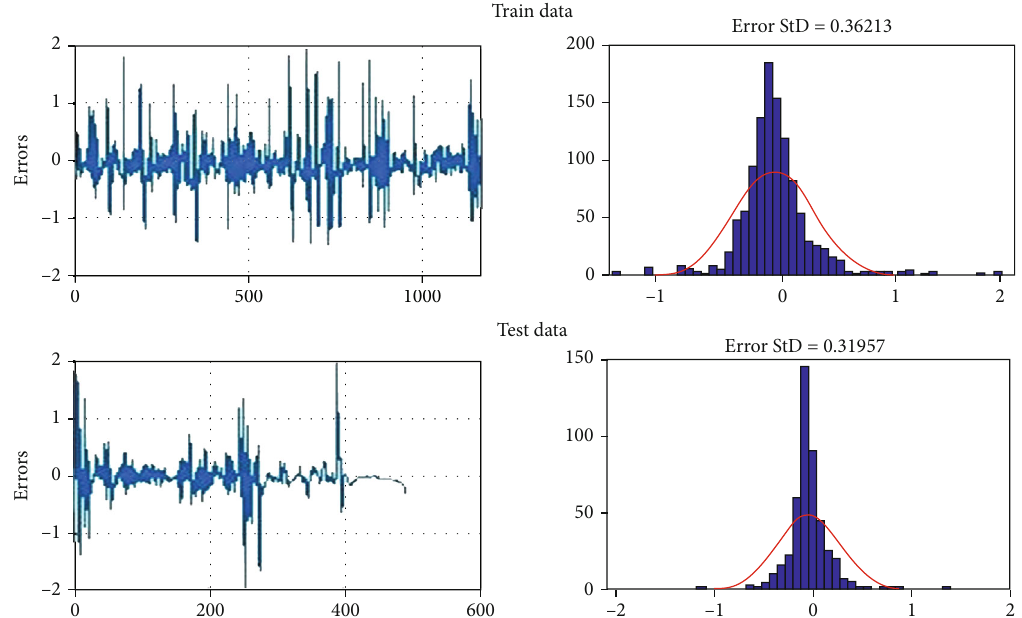
Figure 7: Histogram error and mean error of the LSTM model in the training and testing